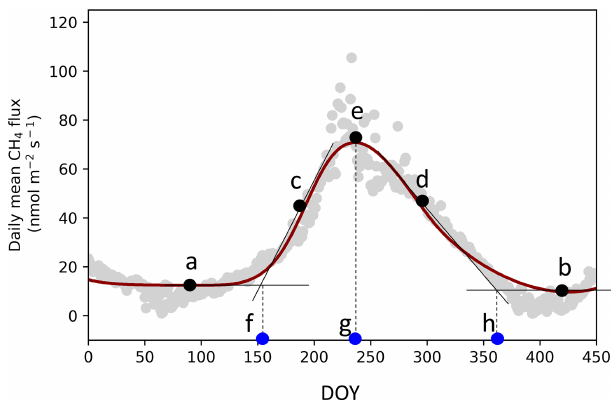
Figure 1. TIMESAT parameter description. (a, b) Base values (TIMESAT reports the average of these two values), (c, d) slopes of seasonal curves (lines drawn between 20% and 80% of the am- plitude), (e) peak value, and day of year (DOY) for the start (f) , peak (g) , and end (h) of the elevated methane (CH 4 ) emission sea- son. Data points are the mean daily gap-filled CH 4 fluxes from site JP-Bby in 2015.